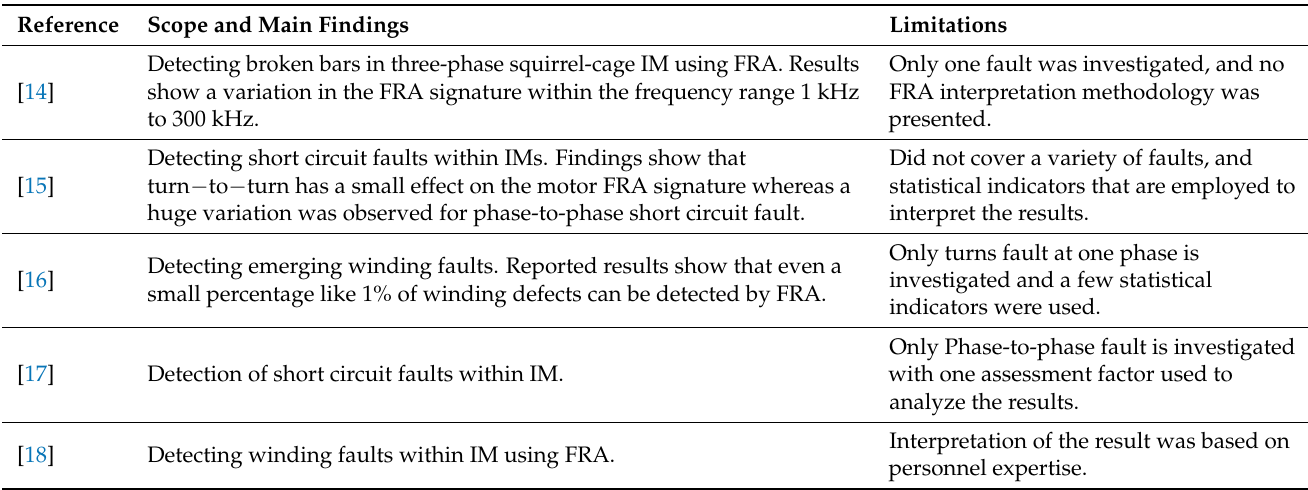
Table 4. Research published on the application of the FRA on induction